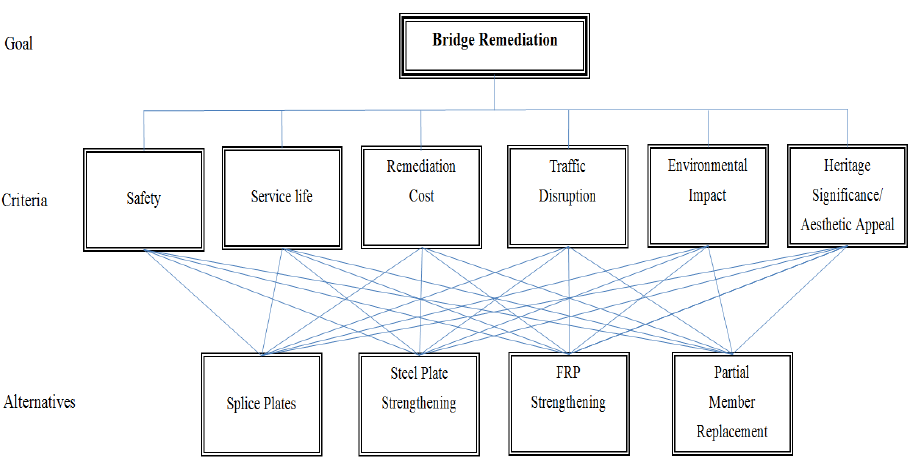
Figure 6. Three Level Hierarchy Structure for Remediation of Bateman’s Bay Bridge.